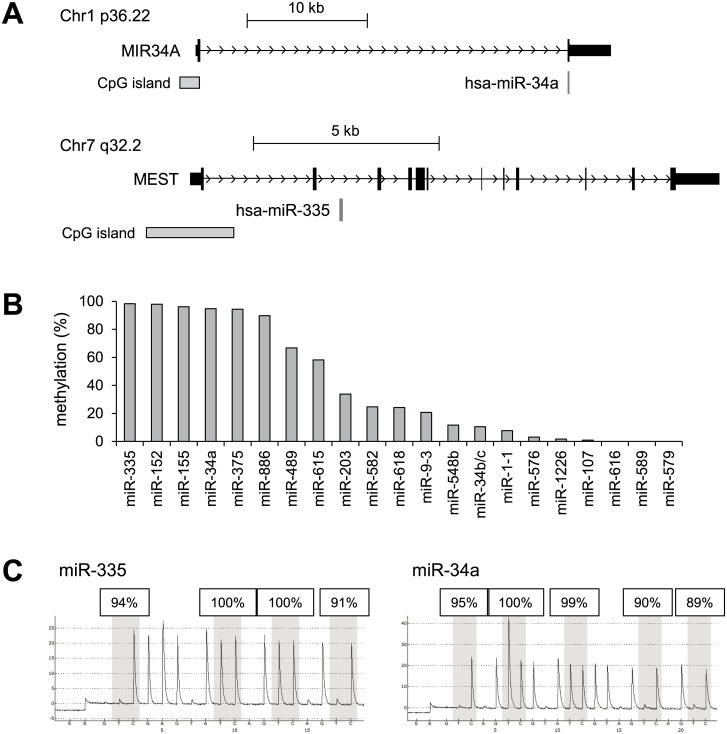
Analysis of CGI methylation at predicted transcription start sites of miRNA genes.(A) Representative examples of miRNA gene structures. Host genes encoding miR-34a and miR-335 are shown. CGIs and pre-miRNA regions are shown below. (B) Levels of CGI methylation in the selected miRNA genes were analyzed using bisulfite pyrosequencing in GIST-T1 cells. (C) Results of bisulfite pyrosequencing of miR-335 and miR-34a in GIST-T1 cells.